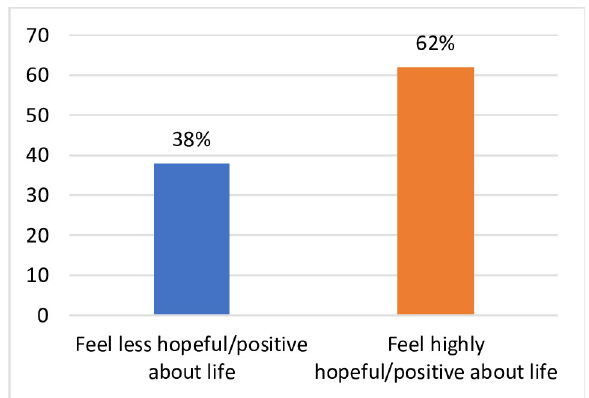
Fig 2. Percent of respondents feeling positive/hopeful during COVID-19. South Australia 2020. Source: Figures generated by the authors from results of Impact of COVID-19 on the wellbeing of individuals in South Australia 2020 survey.